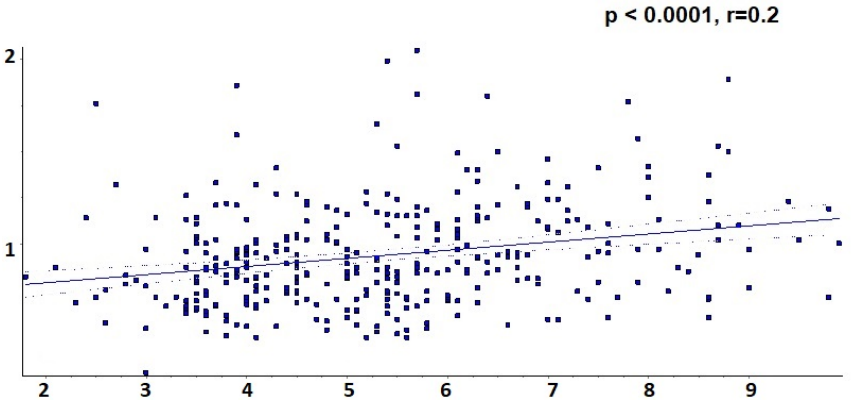
Figure 7. Univariate linear regression between Apo B and uric acid